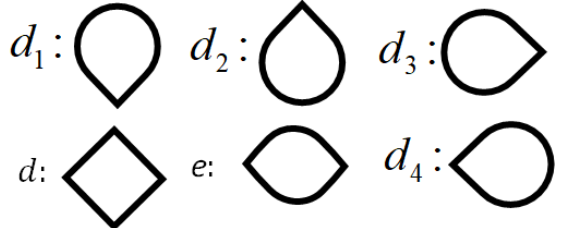
Figure 10. A set of primitive “Kolam”